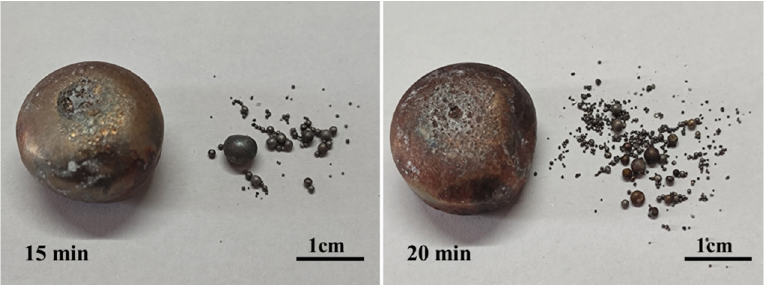
Figure 14. Alloy morphology and metal particles in slag of Fe-13Mn-5Al alloy and low SiO 2 flux.